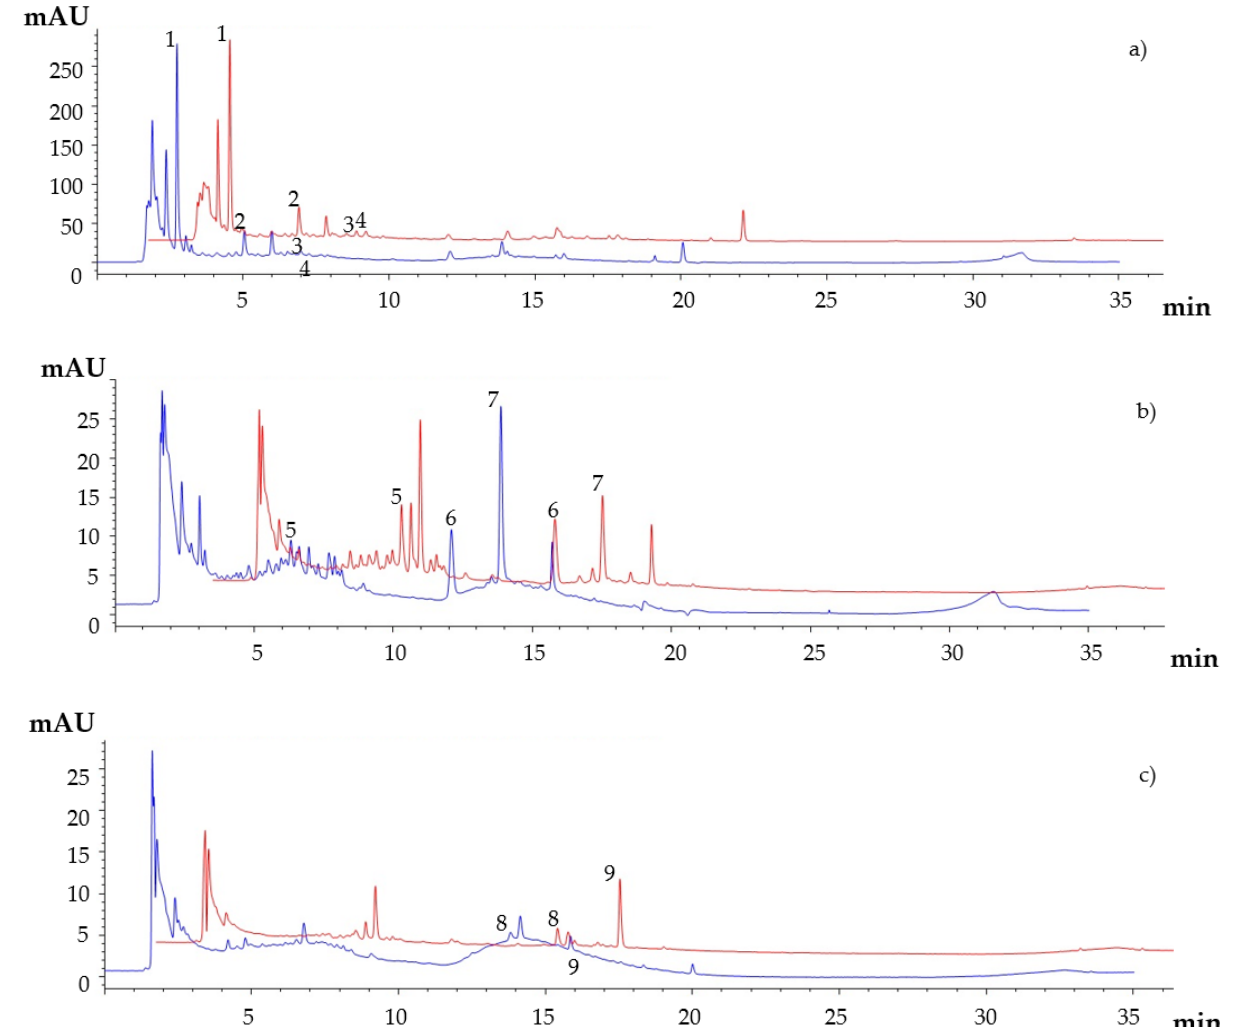
Figure 5. HPLC-DAD chromatograms at ( a ) 280 nm, ( b ) 330 nm, ( c ) 360 nm of traditional (blue line) and UAE (red line) carob syrup diluted 1:3. 1: gallic acid (2.733 min), 2: procyanidin B 1 (5.001 min), 3: procyanidin B 2 (7.091 min), 4: epicatechin (7.879 min), 5: chlorogenic acid (6.229 min), 6: 4-hydroxycoumaric acid (12.205 min), 7: ferulic acid (13.939 min), 8: my- ricitrin (13.531 min), 9: quercitrin (15.701 min).